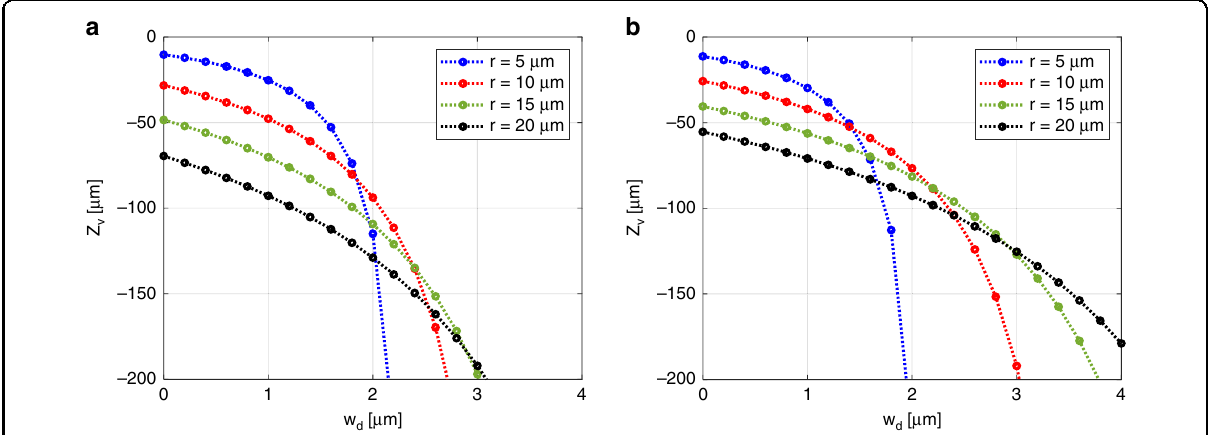
Fig. 3 Simulated results of axial position Z v vs w d for microspheres with radii of 5, 10, 15, and 20 µm. a SLG ( n = 1.52 and λ = 524 nm) and b PS ( n = 1.60 and λ = 524 nm). n represents the refractive index for a speci fi c wavelength λ . Z v represents the relative position of the virtual image from the sample. As w d increases, the magni fi ed super-resolution image is formed at a lower